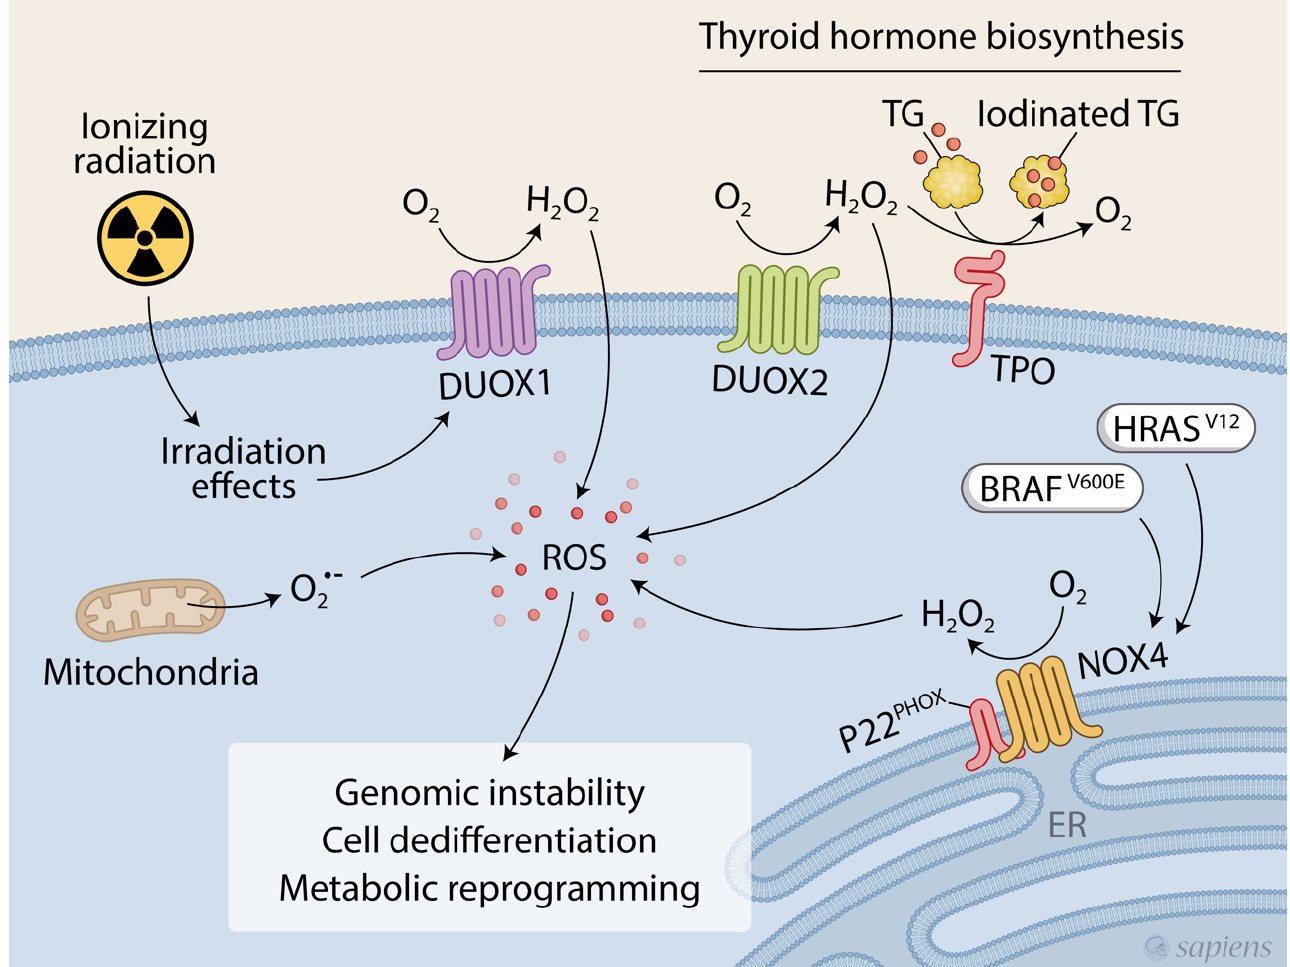
Figure 1. The role of oxidative stress in thyroid carcinogenesis. A pro-oxidant environment is associated with thyroid tumorigenesis, and NADPH oxidases have been described as important ROS sources. Ionizing radiation, a risk factor for thyroid cancer, induces DUOX1-dependent H 2 O 2 production, resulting in DNA damage and potentially genomic instability. NOX4 is upregulated in PTCs and is positively regulated by the oncogenes BRAF V600E and HRAS V12 . Increased NOX4 has been implicated in thyroid cancer dedifferentiation and genomic instability. DUOX2 is the source of H 2 O 2 for thyroid hormone biosynthesis in the apical membrane of thyrocytes, but its role in thyroid carcinogenesis is unclear.